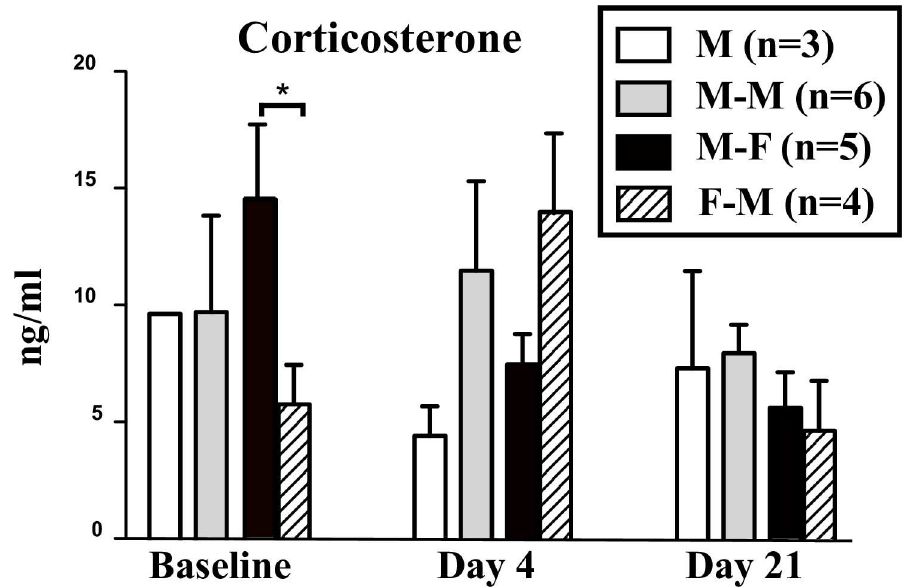
Fig 9. Plasma corticosterone concentrations measuredin the 4 experimental groups before the experiment and after 4 and 21 days of exposure to the different social conditions. * = p < 0.05.